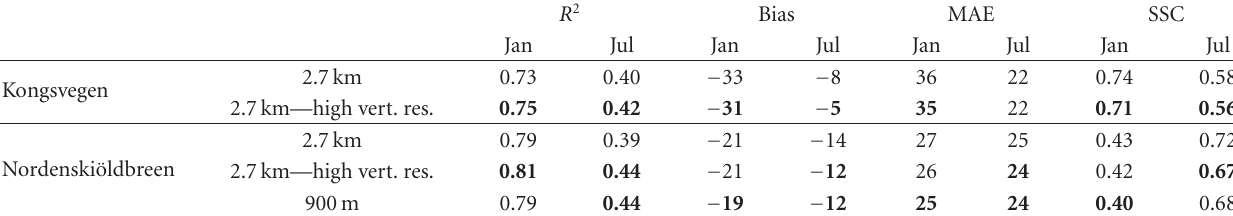
Table 15: Long-wave radiation statistics in summer and winter 2009-2010 in 2.7km resolution, with and without increased vertical resolution in the boundary layer (high vert. res.), and in 900 m resolution. Bold numbers indicate the best result for each AWS. Vestfonna data are not used here because of the lack of data during the chosen period. R 2